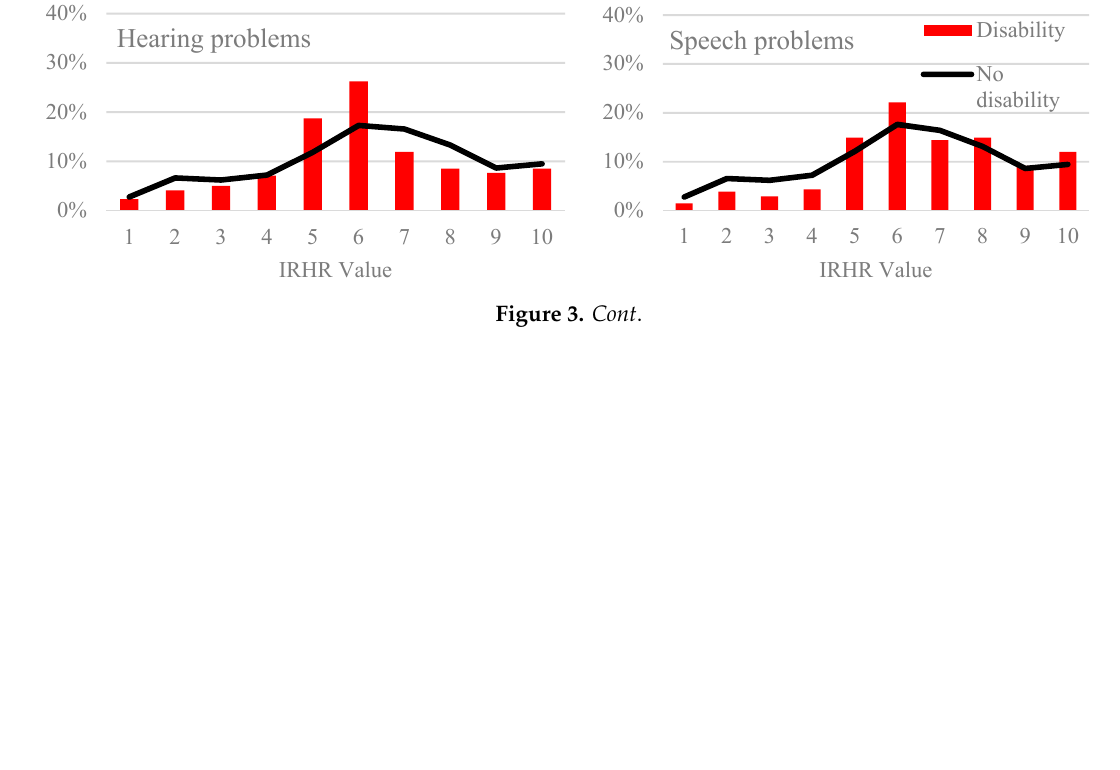
Figure 2. Index of Relative Homelessness Risk by all disability and long-term conditions versus no impairment (pre-NDIS).